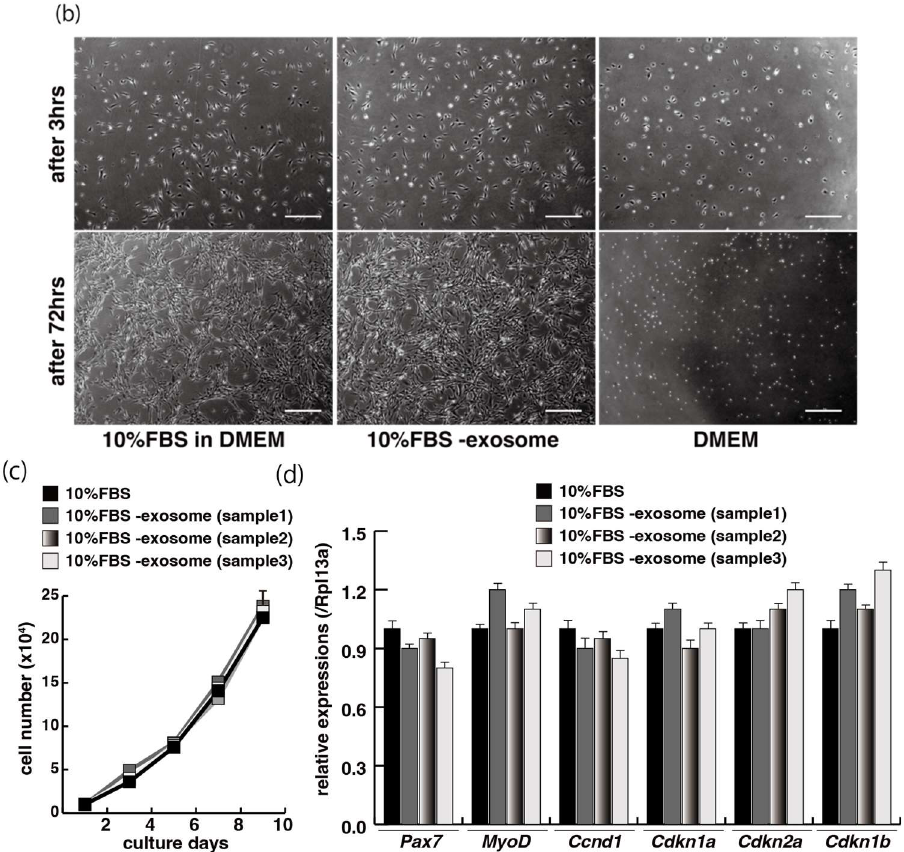
Figure 1. Exosome-depleted serum does not affect myogenic cell growth. ( a ) Cultured C2C12 cells with different dilutions of fetal bovine serum (FBS); ( b ) morphology of growing C2C12 cells with or without exosome in FBS (10%FBS in DMEM or 10%FBS − exosome) and without serum (DMEM); ( c ) C2C12 cells grow in the condition with or without exosomes (sample1–3); ( d ) relative mRNA expression of myogenic stem cell ( Pax7 ), myogenic commitment to differentiation ( MyoD ), and cell cycle ( Ccnd1 , Cdkn1a , cdkn2a , Cdkn1b ) markers in C2C12 cells cultured with or without exosomes in FBS. All Scale bar = 100 μm. Data represent means ± SEM ( n = 3). The statistical analysis was performed by Mann–Whitney U test.